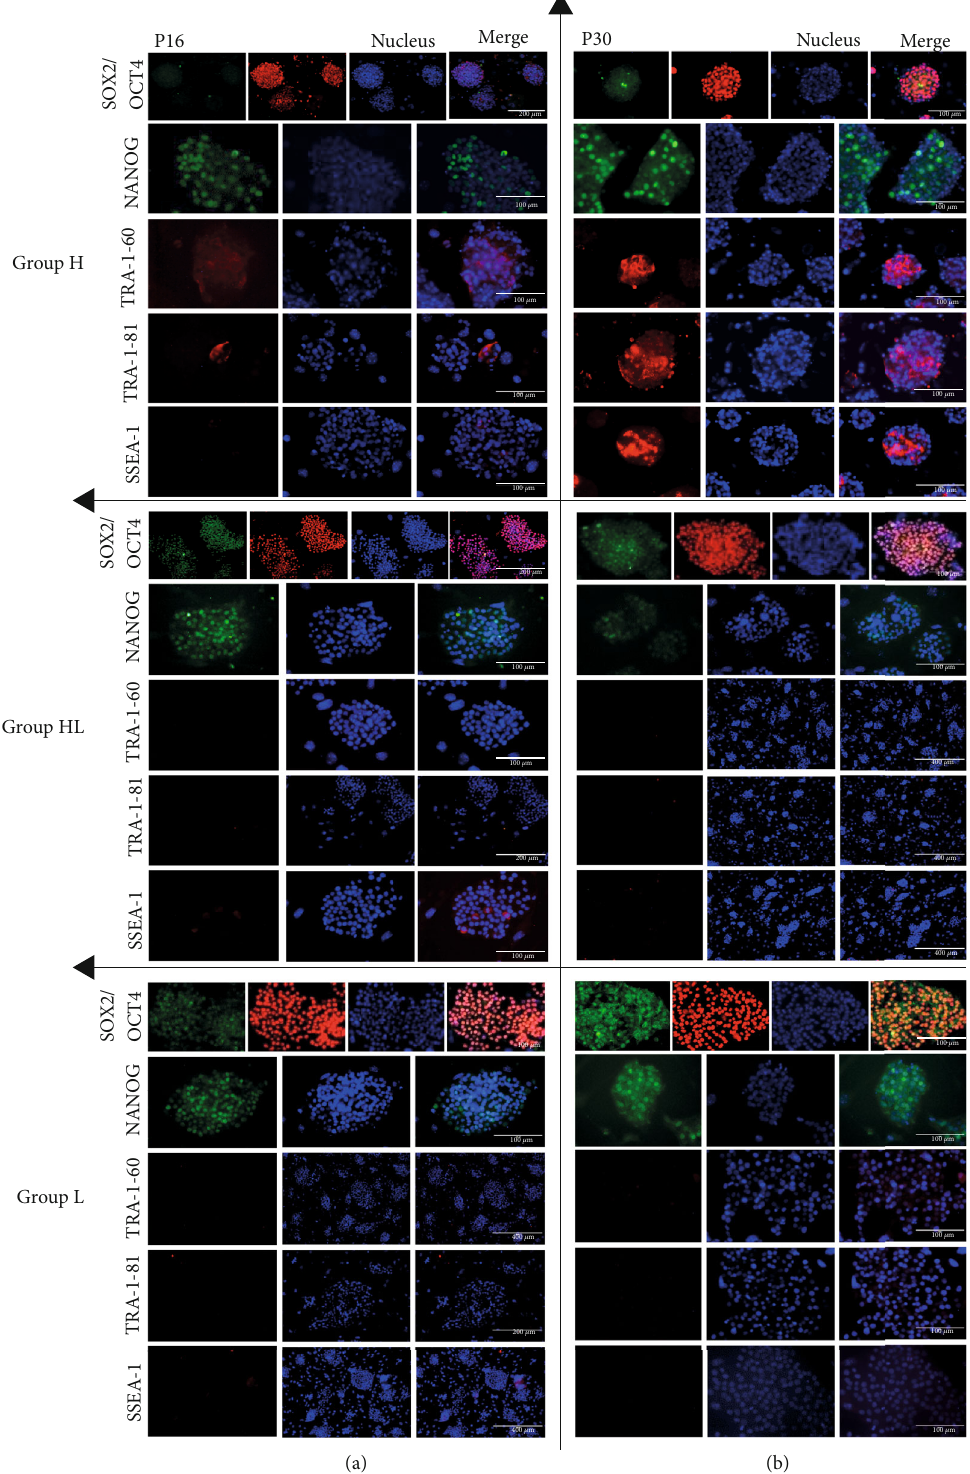
Figure 2: Immunocytochemistry of eiPSC colonies showing positive and negative results for pluripotency markers SOX2, OCT4, NANOG, TRA-1-60, TRA-1-81, and SSEA-1 for groups H, HL, and L in passages 16 (a) and 30 (b). Scale bars: 100 μ m, 200 μ m, and 400 μ